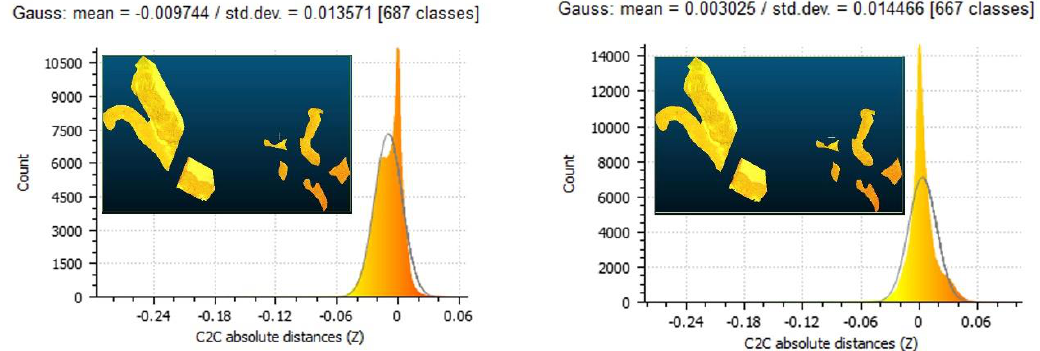
Figure 27. Comparison between points clouds: laser scanner vs photogrammetry in vertical flight (A, left ), laser scanner vs photogrammetry in vertical + oblique flight (C, right ).